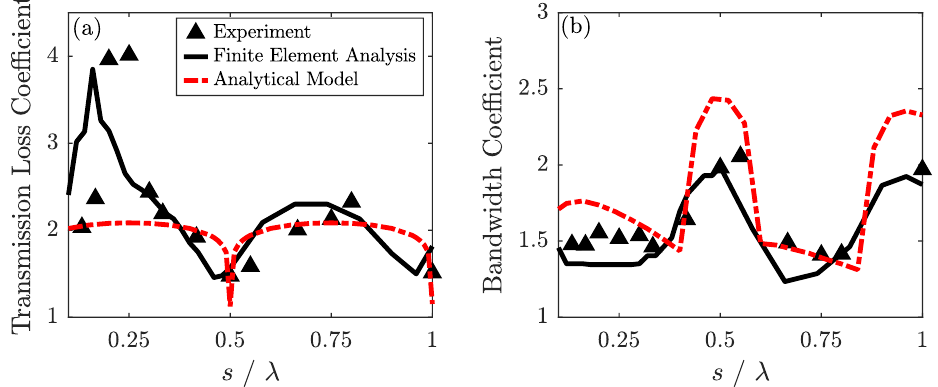
Figure 6. ( a ) Normalised transmission loss comparison for different spacing configurations; ( b ) Bandwidth Coefficient ∆ f / ∆ f o comparison for different spacing